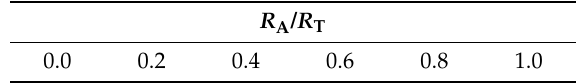
Figure 3. Geometrical definition of double-pass die.